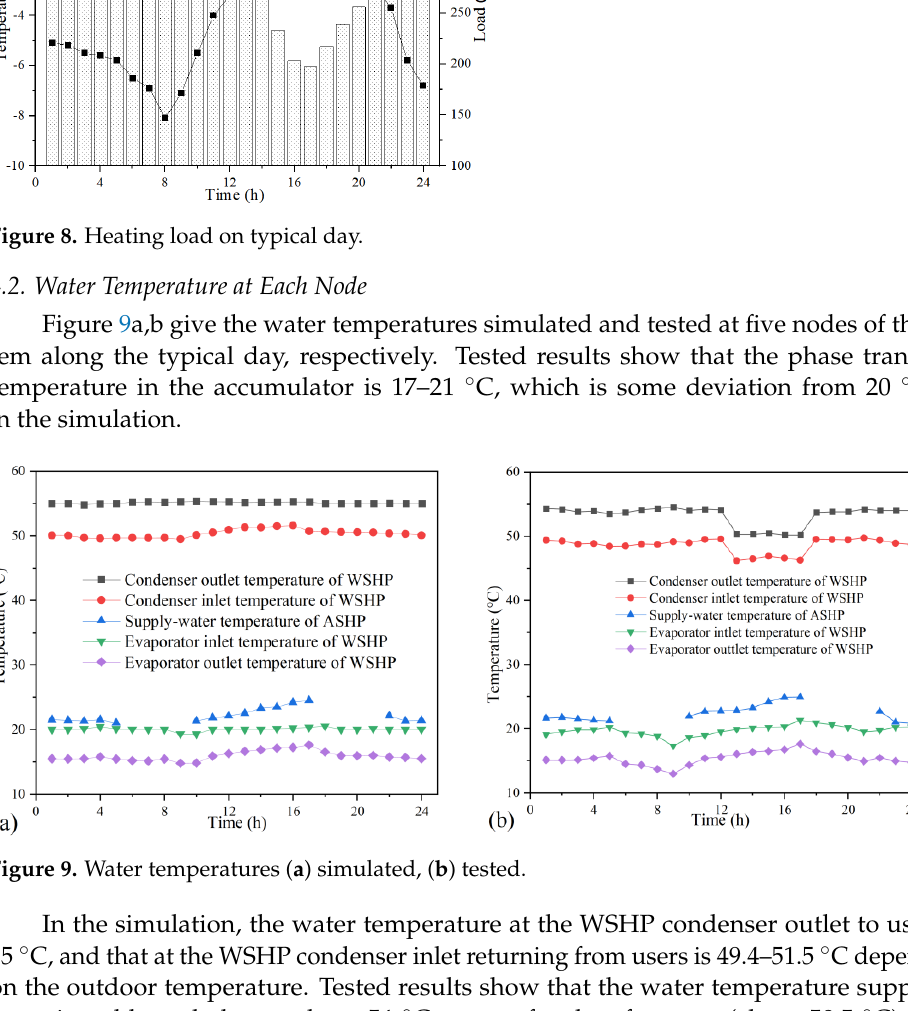
Figure 9. Water temperatures ( a ) simulated, ( b ) tested.